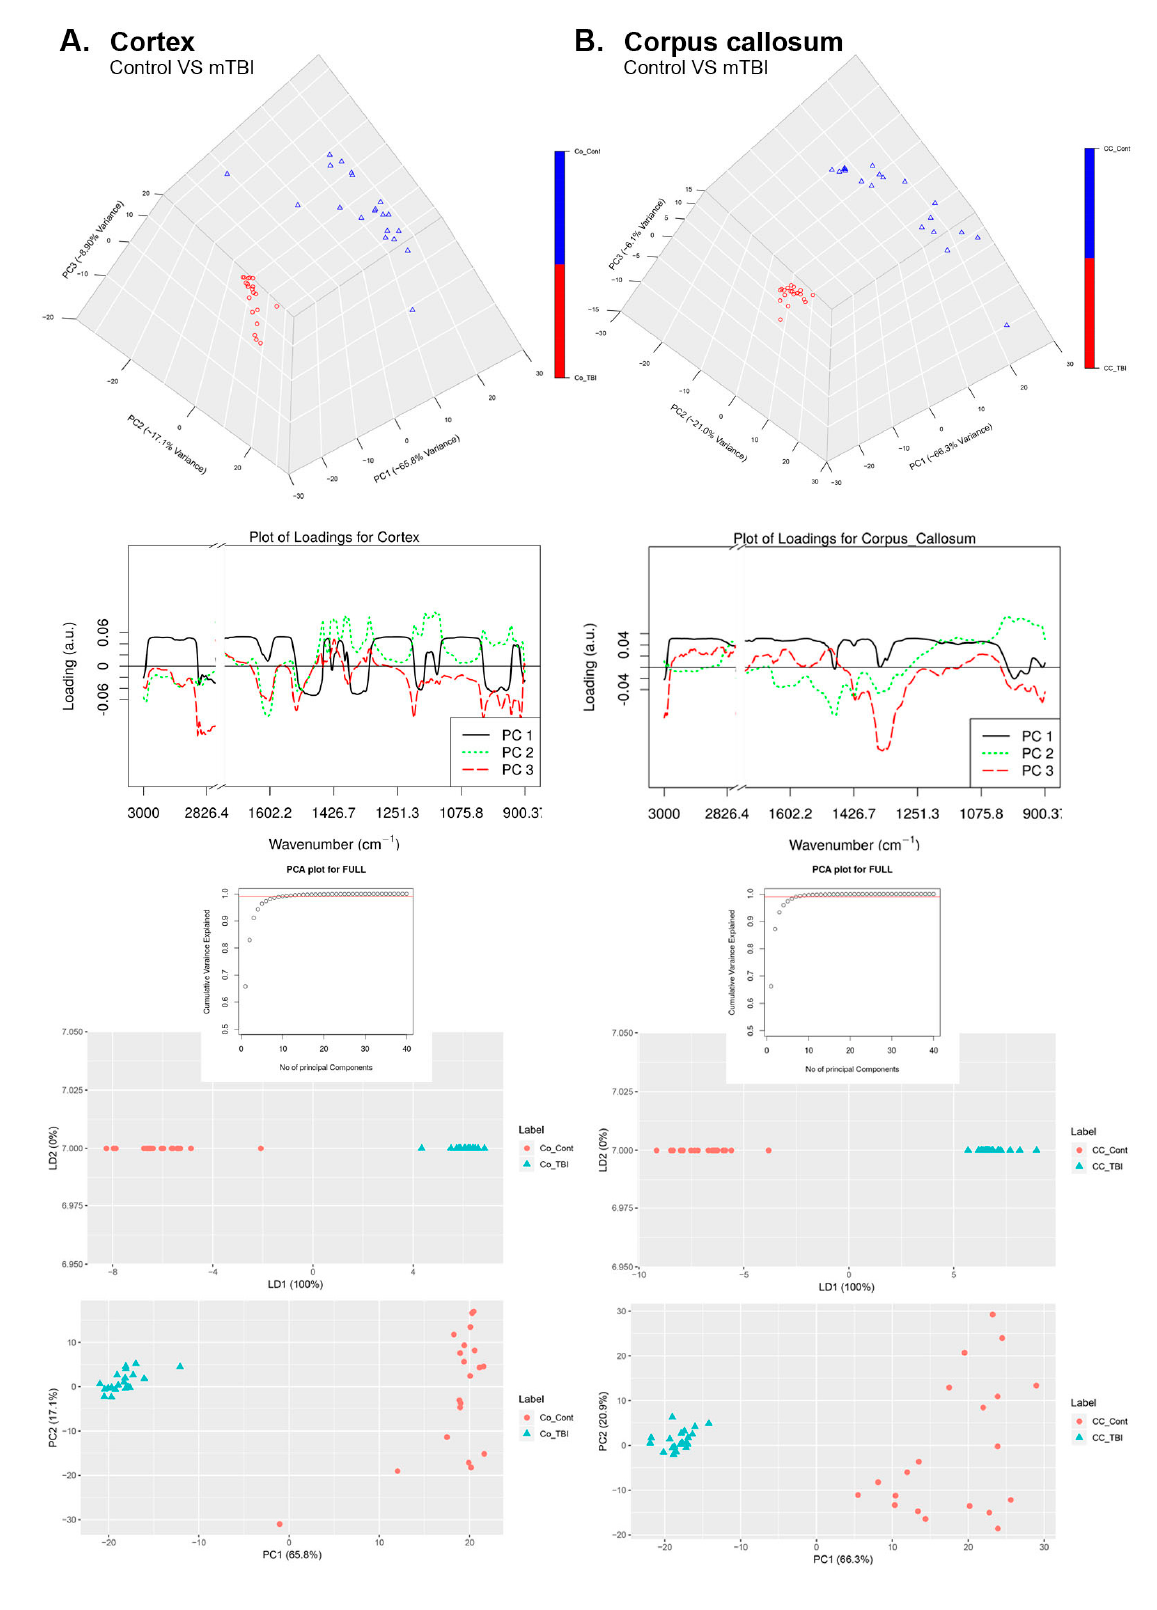
Figure 5. Principal component analysis of control and mTBI groups. Supervised linear discriminant analysis (LDA) is presented besides relative loading plots and the score plots are presented to emphasize the significant differences in the data collected from control and mTBI FTIR spectra in ( A ) Co and ( B ) CC.